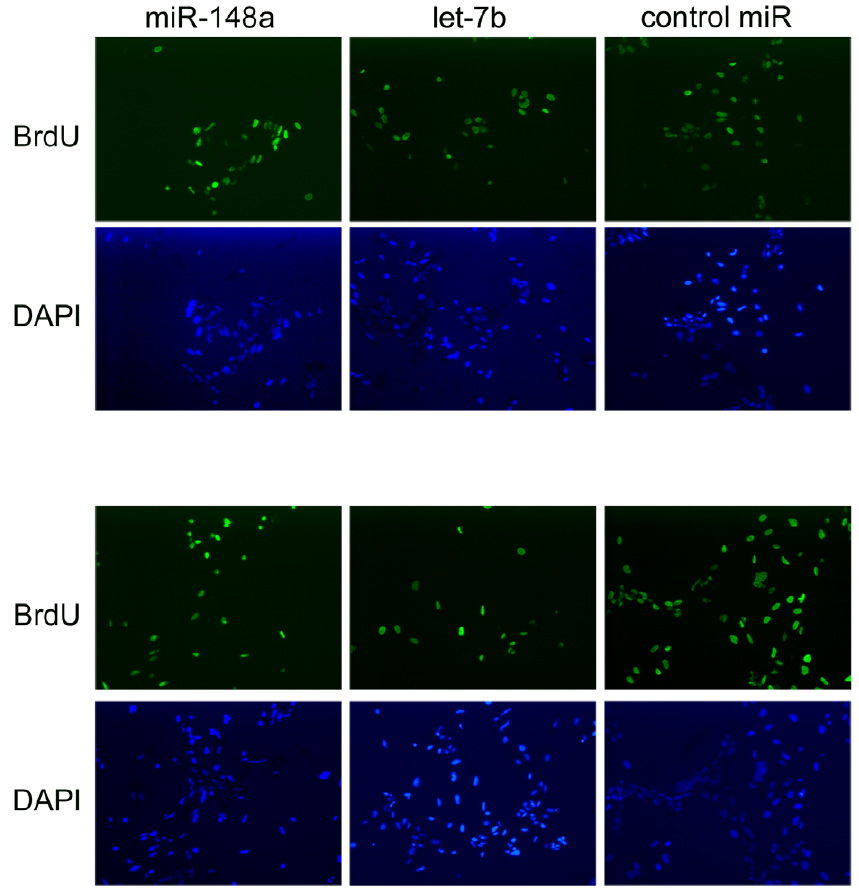
Figure 4. Proliferation experiments. Examples of proliferating cells transfected with miR-148 or let-7b. Top panels are dorsal PECs and low panels are ventral PECs. doi:10.1371/journal.pone.0012058.g004 PLoS ONE |